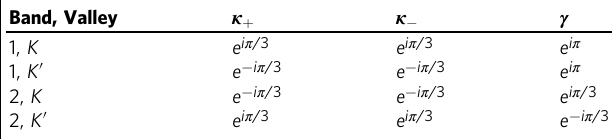
Table 1 C 3 z eigenvalues of the fi rst two bands from each valley, computed from large-scale DFT wavefunctions at high symmetry momentum